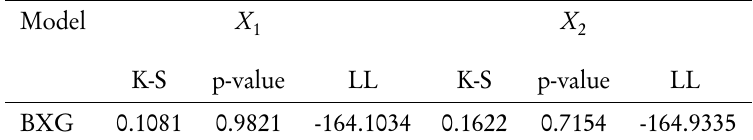
Kolmogrove-Smirnov goodness of fit test statistic with p-value and maximized log-likelihood (LL) for the marginal of XG